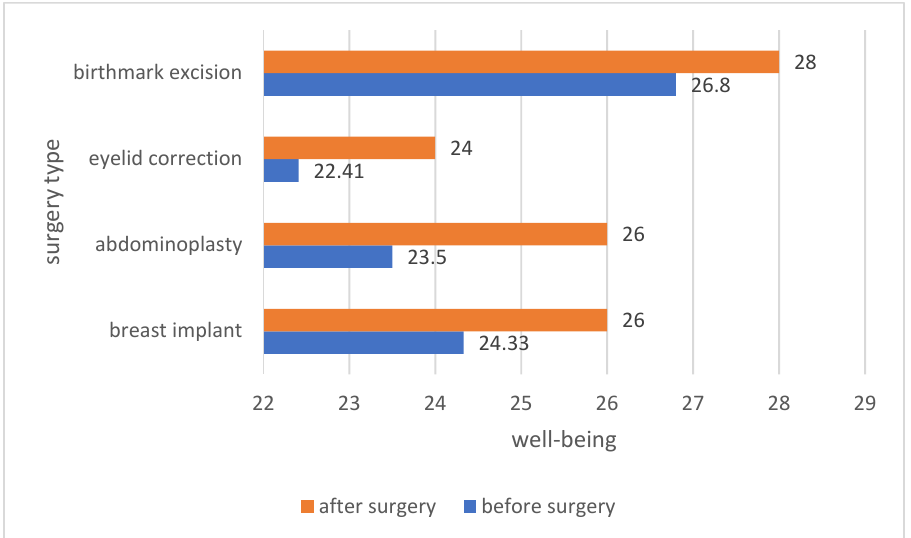
Figure 7. Comparison of the sense of well-being among patients before and after the procedure.